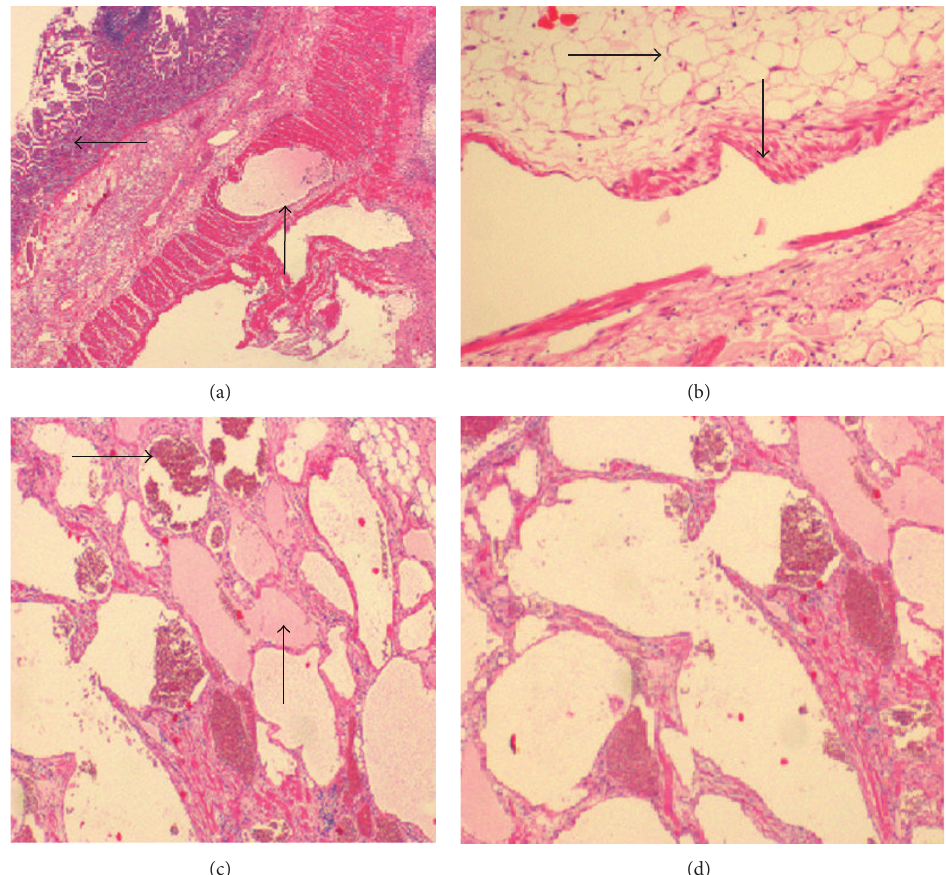
Figure 3: Histology images of the reported small bowel hamartoma. (a) Normal small intestinal mucosa top arrow and dilated thin-walled vascularspacesinthemuscularispropriabottomarrow.(b)Highpowerviewingofthevascularlesioninwhichadilated,vein-likebloodvessel with some smooth muscle fibres in the wall bottom arrow and adipose tissue top arrow. (c) A closer view of the lesion, with many closely packed vascular and lymphatic spaces within the bowel wall, contains blood (top arrow) and proteinaceous lymph-like material (bottom arrow), respectively. (d) Magnified view of the aggregated abnormal vascular “some have prominent muscular wall” and lymphatic